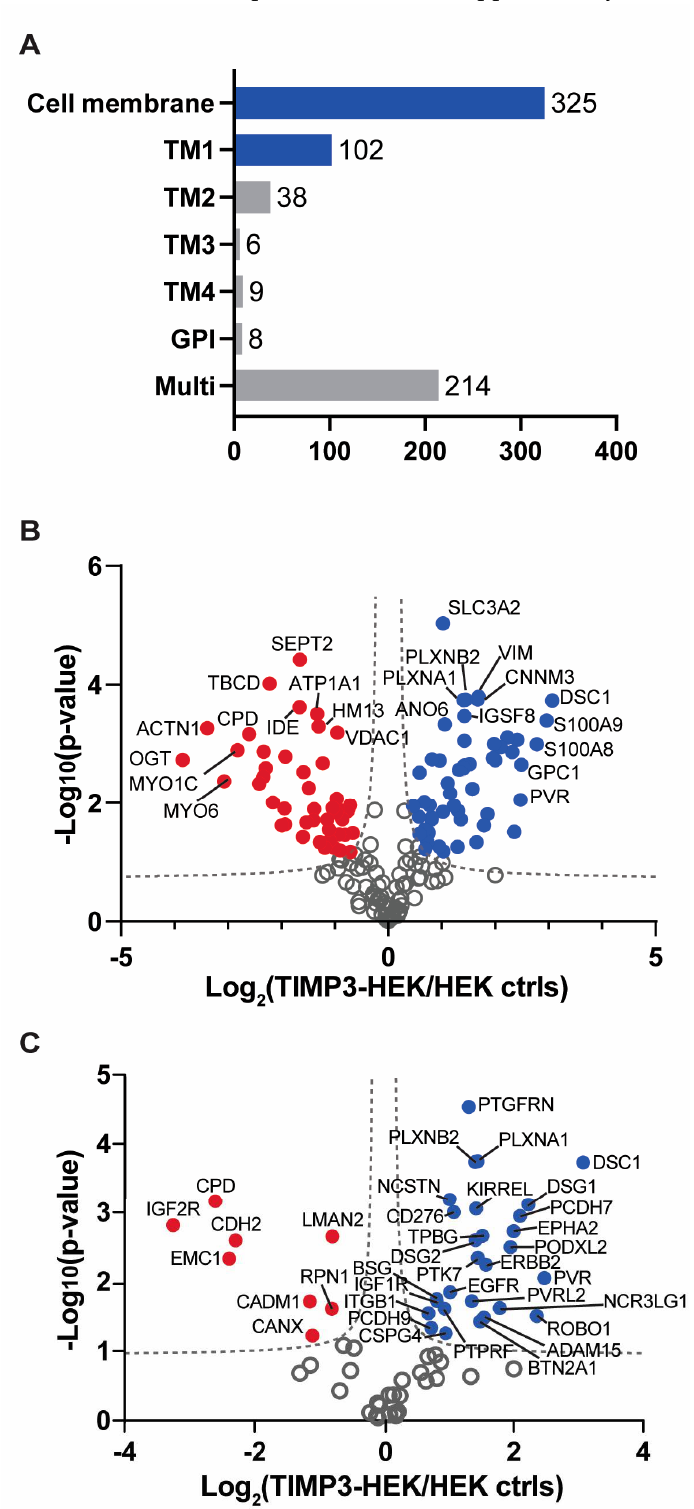
Figure 1. Analysis of cell membrane composition of TIMP-3 overexpressing cells. ( A ) Number and topology of membrane proteins detected in the surfaceome of TIMP-3/HEK cells. ( B ) Volcano